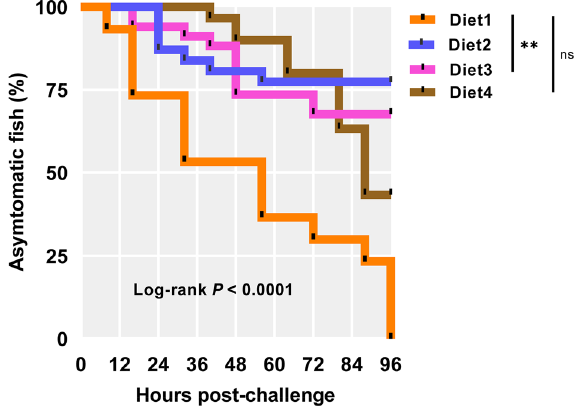
Figure 5. Variation in the infection rate in fish fed different levels of PBM concurrently supplemented with TH and HI larvae after 96 h post-challenge by injection with V. harveyi . Infection started in Control at 8 h post challenge (hpc) and while infection started at 24 hpc in 80PBM 10TH+10HI , 16 hpc in 85PBM 5TH+10HI and 40 hpc in